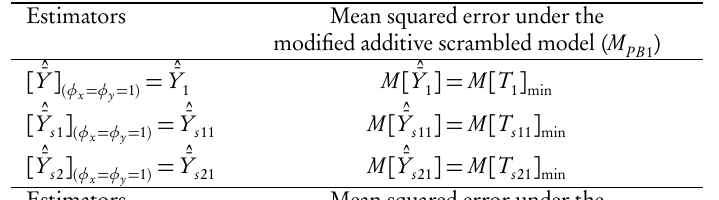
Mean squared error of the estimators